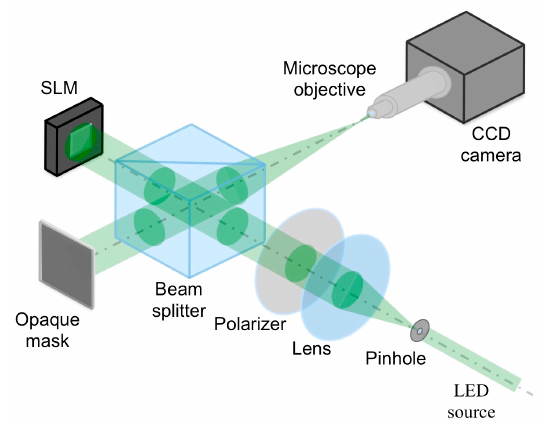
Figure 7. Setup for diffractive lens evaluation. Illumination is done with an LED source and a 100 micron pinhole. A polarizer selects the appropriate incidence on the SLM display. A microscope objective is attached to the charged coupled device (CCD) camera to capture the focal planes. Light coming from the mirror was blocked with an opaque mask.